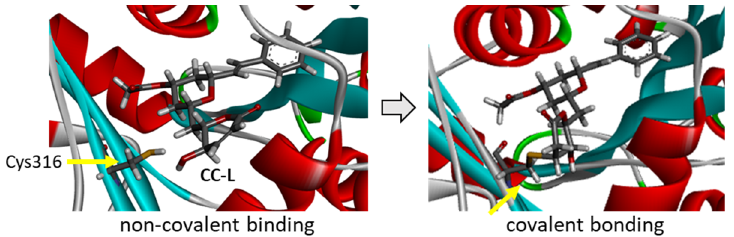
Figure 6. Models of cryptoconcatone L (CC-L) interacting with α -tubulin. The left view shows the ligand inserted into the binding cavity prior to reacting with the proximal thiol group of the Cys316 residue. The right view shows the ligand covalently bound to the Cys316 residue, as highlighted.